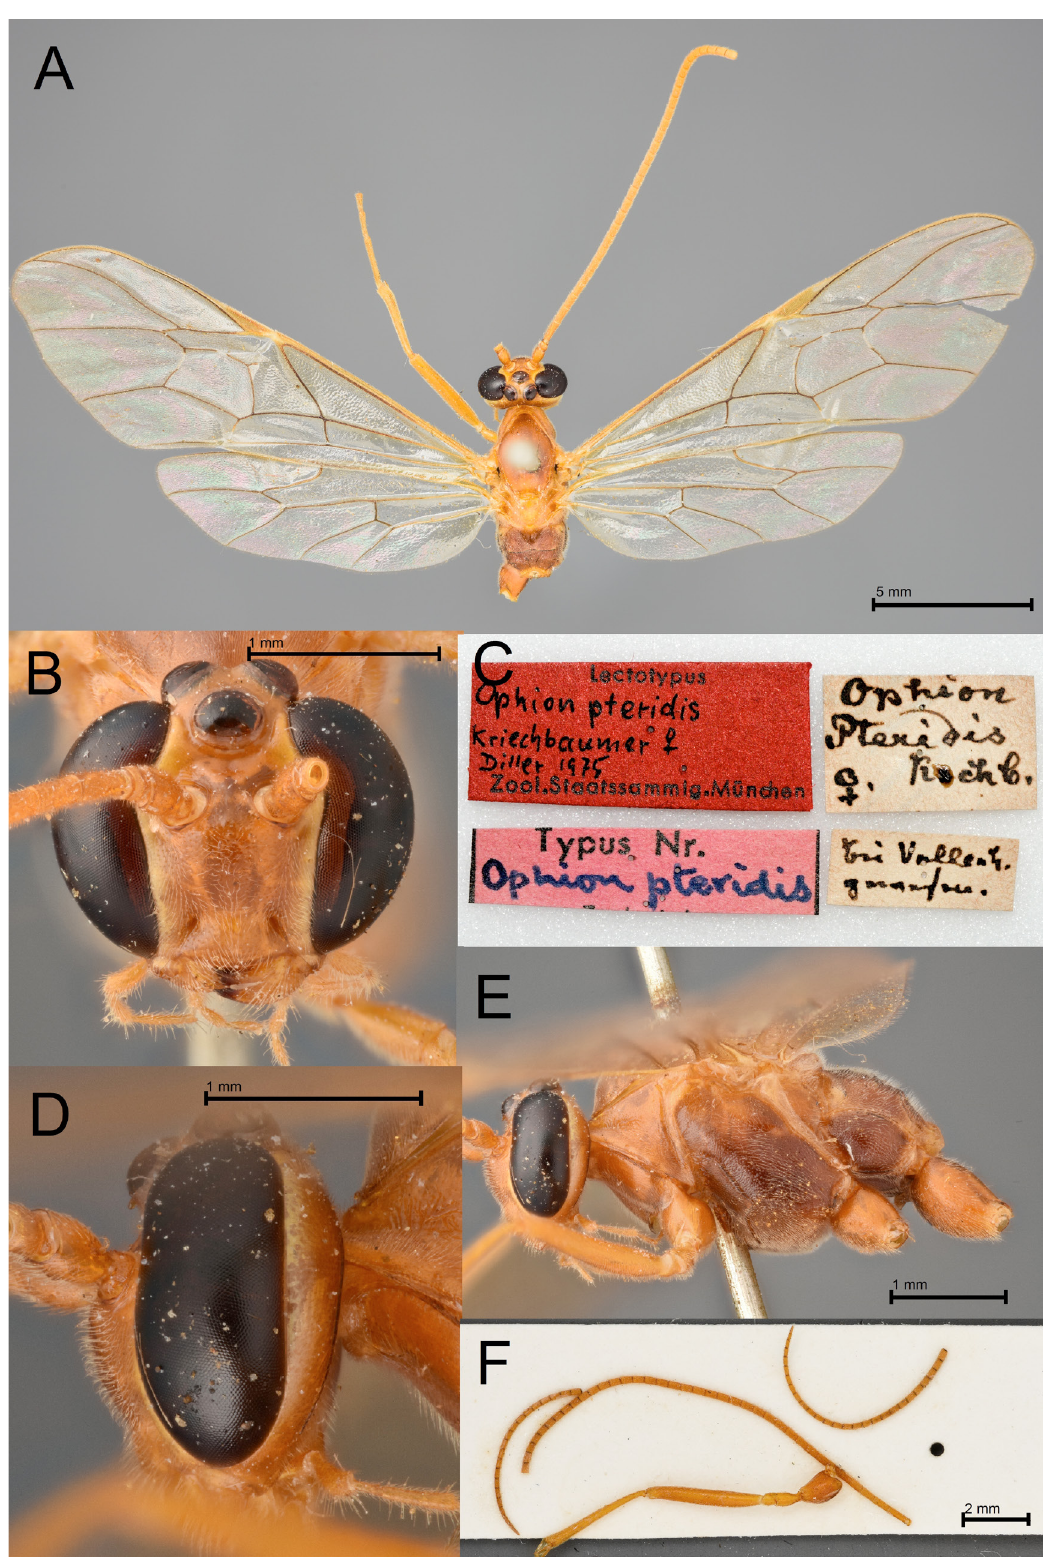
Fig. 52. Ophion pteridis Kriechbaumer, 1879, lectotype, ♀ (ZSM). A . habitus, dorsal view. B . head, anterior view. C . Labels. D . head, lateral view. E . Mesosoma, lateral view. F . Parts of antennae and